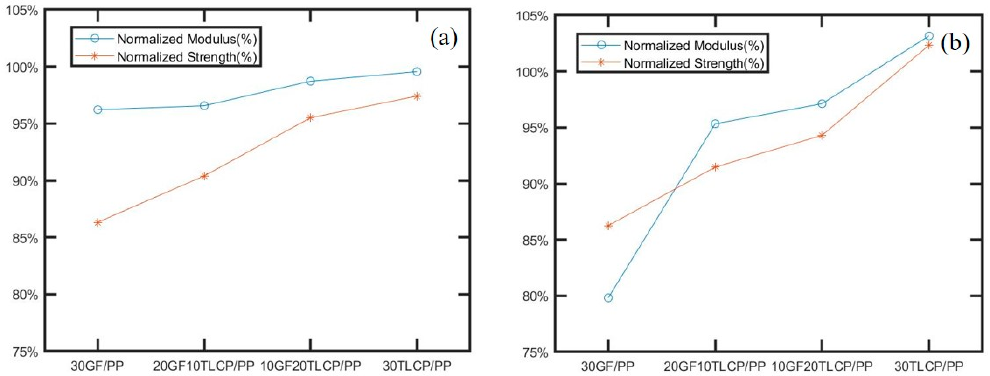
Figure 10. Percentage of mechanical properties of the recycled composite to pristine composite in ( a ) flow direction and ( b ) transverse-to-flow directions. Table 2. The knock down (KD) factor of the in situ hybrid composite. Material KD (Modulus) KD (Strength)